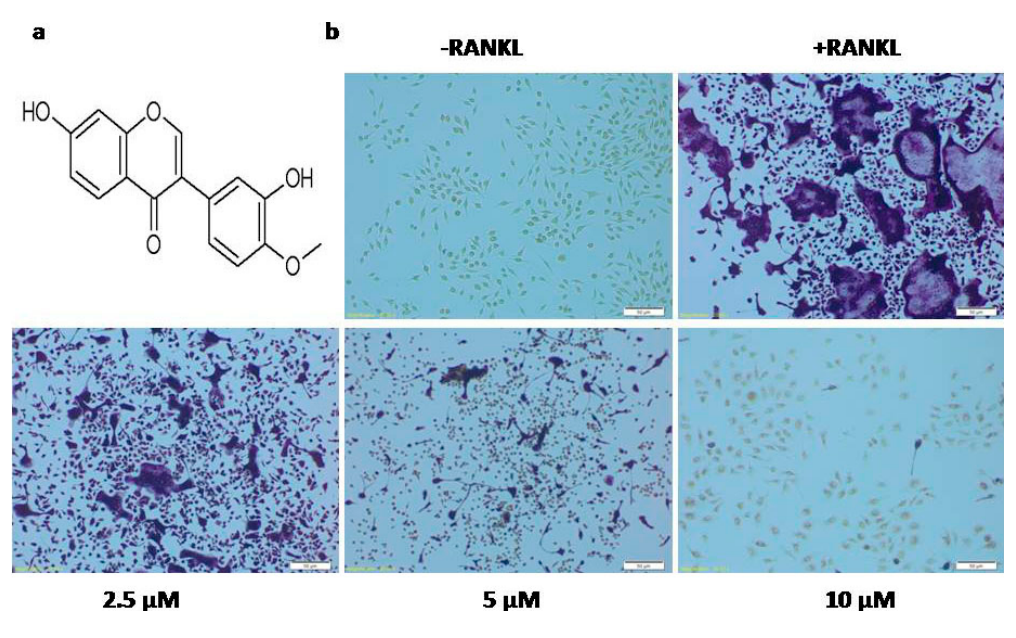
Figure 1. Cont. Figure 1.